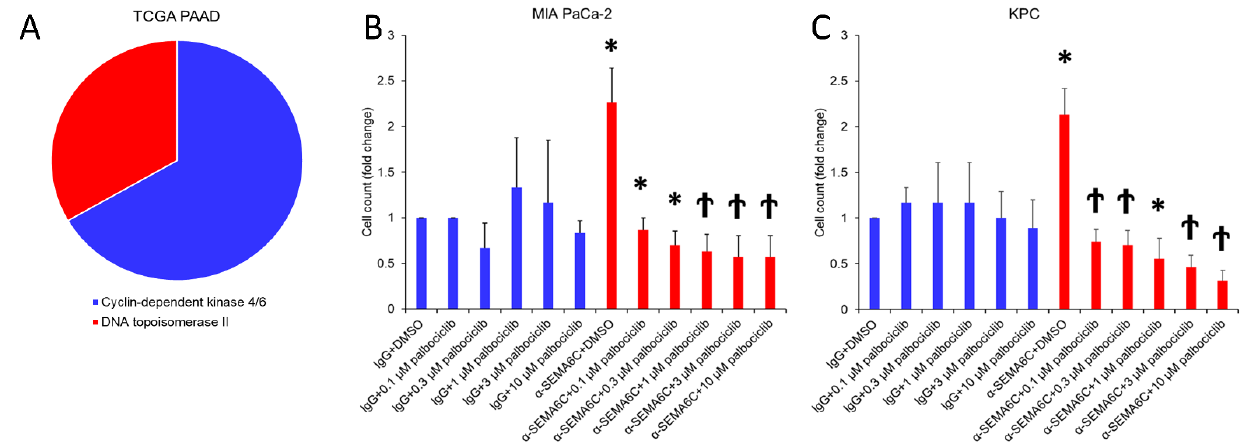
Figure 5. CDK4/6 inhibitor Palbociclib suppresses proliferation in SEMA6C-low pancreatic cancer. TCGA-based and L1000CDS 2 -predicted SEMA6C-mimicking therapeutics are shown ( A ) and CDK4/6 inhibitor was selected for in vitro validation of proliferation in MIA PaCa-2 ( B ) and KPC ( C ). * represents p < 0.05; † represents p < 0.01.